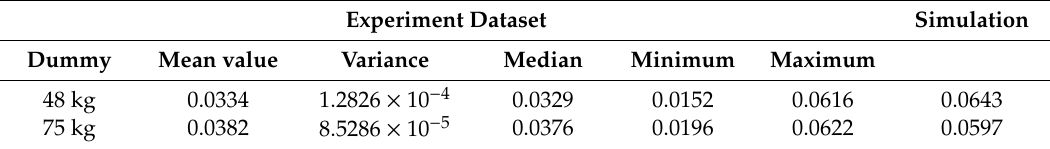
Figure 18. Comparison of simulated acceleration and experimental acceleration time history. Table 7. Comparison of peak vertical acceleration from sensor 4 at position 2 (unit: g).